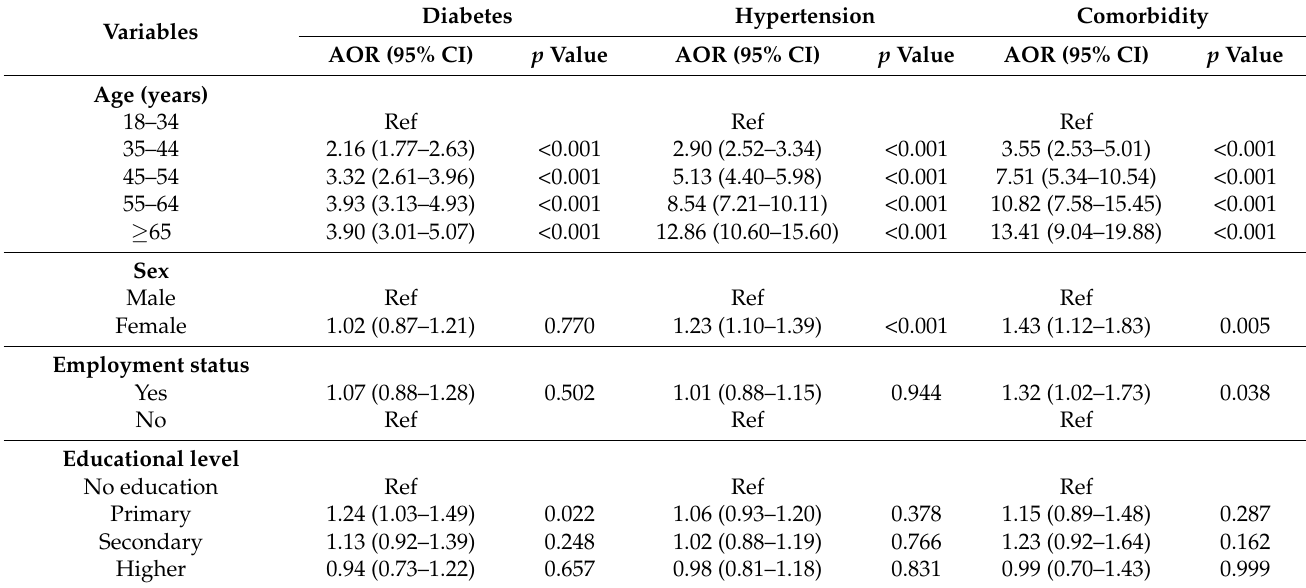
Table 3. Regression analysis of factors associated with diabetes, hypertension, and comorbidity ( n =